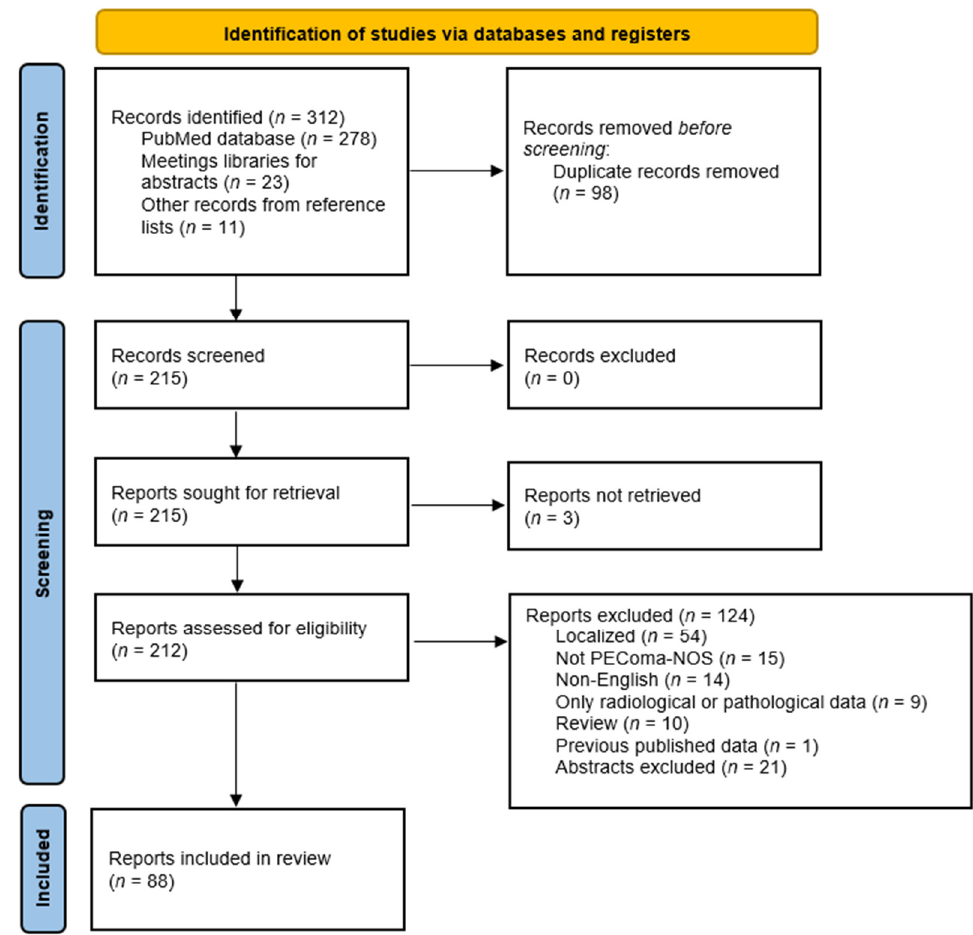
Figure 1. PRISMA flow diagram of the literature search strategy.